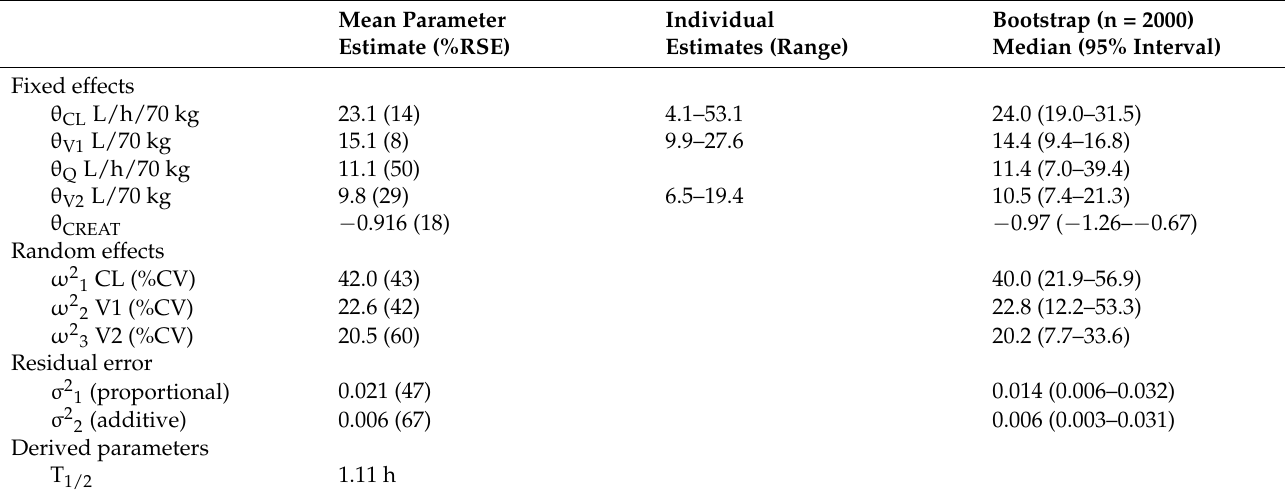
Table 2. Parameter estimates from final benzylpenicillin model.